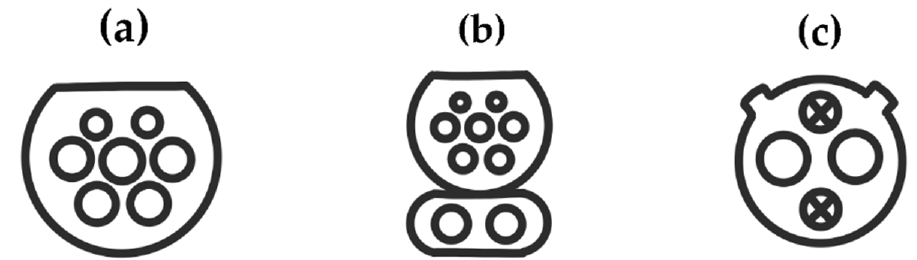
Figure 2. EV connector types: ( a ) Type 2, ( b ) CCS combo 2, and ( c ) Type 4 (CHAdeMO).